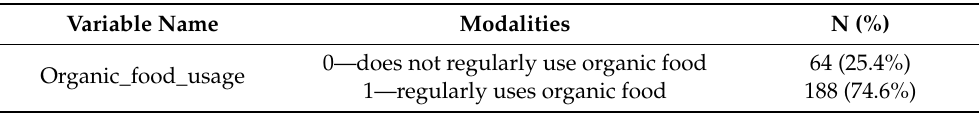
Table 2. Dependent